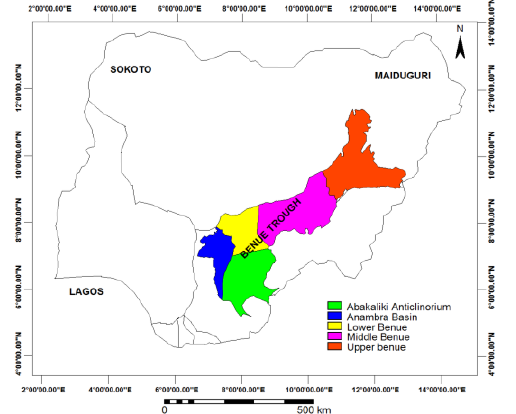
Figure 1. Map of Nigeria showing the major divisions of the Benue Trough . (after Ologun et al